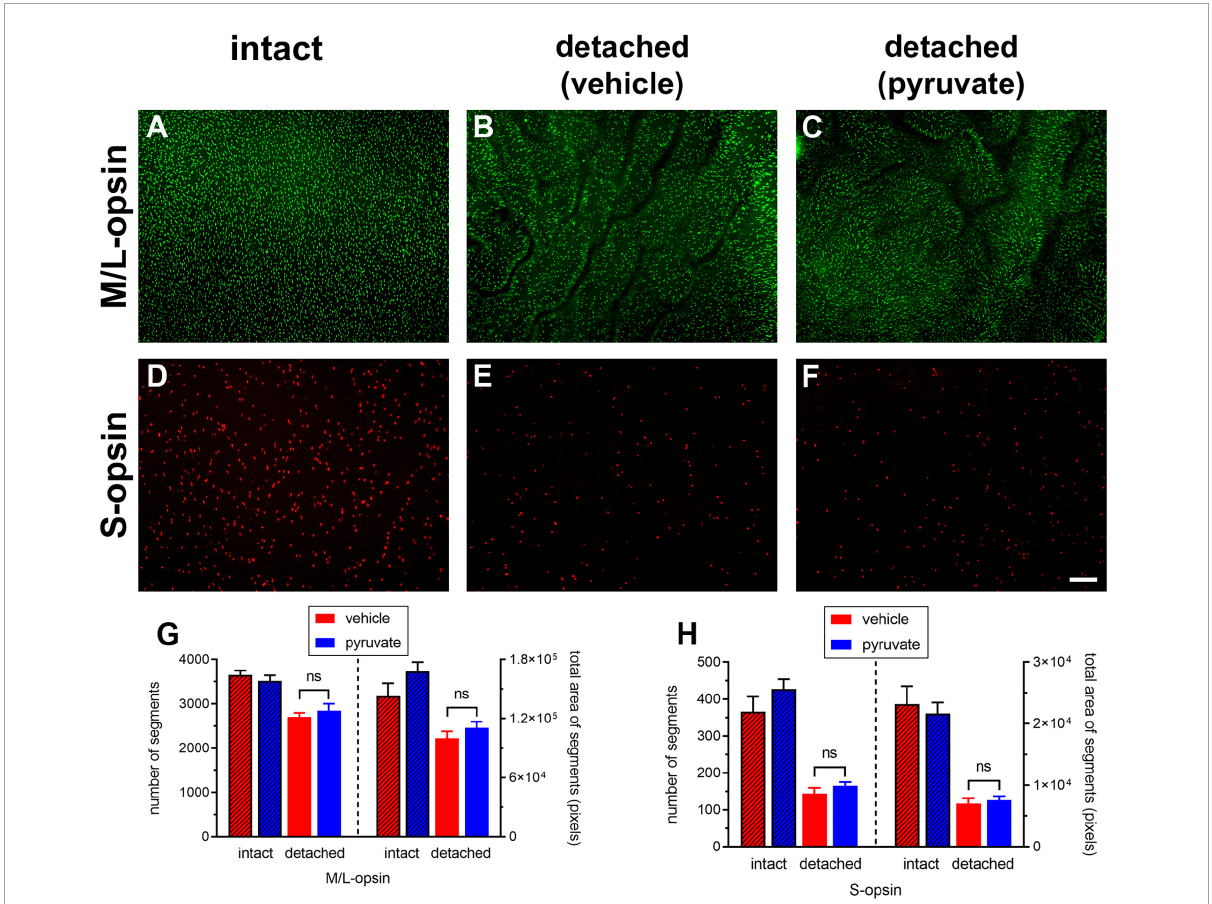
FIGURE10 Short-term pyruvate supplementation fails to protect against loss of M/L-opsin + and S-opsin + cone opsins at 3 days after retinal detachment. (A–F) Representative wholemount images of M/L-opsin + cones and S-opsin + cones in intact retina (A,D) , and at 3 days after detachment in rats administered normal (B,E) or pyruvate-supplemented (C,F) drinking water (B,E) . Scale bar: 100 µ m. (G,H) Quantification of number and total area of M/L-opsin + and S-opsin + cone segments in vehicle-intact, pyruvate-intact, vehicle-detached, and pyruvate-detached groups after detachment. Values represent mean ±